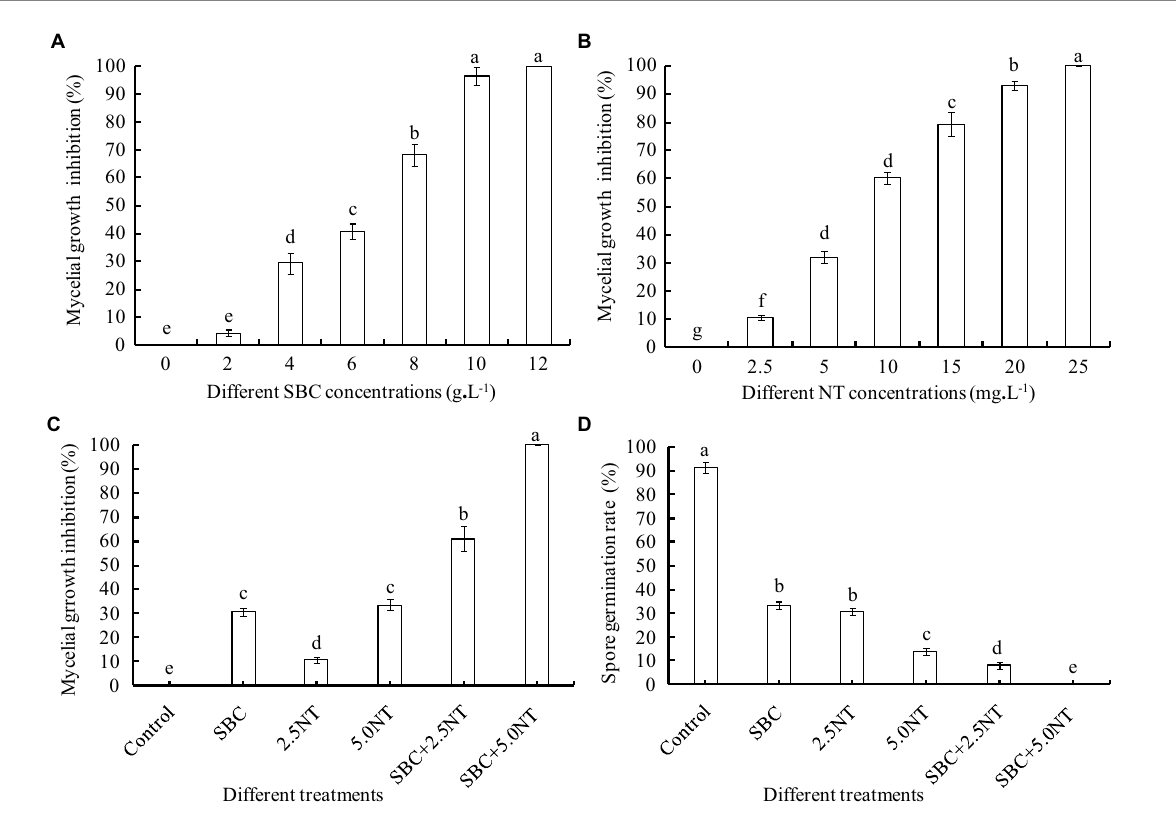
FIGURE 1 Effect of SBC, NT, and combination treatments on the mycelial growth and spore germination of Aspergillus niger . (A) Effect of SBC on colony growth. (B) Effect of NT on colony growth. (C) Effect of SBC and NT combinations on colony growth. (D) Effect of SBC and NT combination on spore germination rate. SBC means 6.0 g/L NaHCO 3 ; 2.5NT means 2.5 mg/L natamycin; 5.0NT means 5.0 mg/L natamycin; SBC + 2.5NT means 4.0 g/L NaHCO 3 + 2.5 mg/L natamycin; and SBC + 5.0NT means 4.0 g/L NaHCO 3 + 5.0 mg/L natamycin. ANOVA was used to compare the mean values of analysis parameters ( p < 0.05). The results are shown as the mean ± standard deviation ( n = 3). Different superscript letters in the same column indicate significant differences ( p <